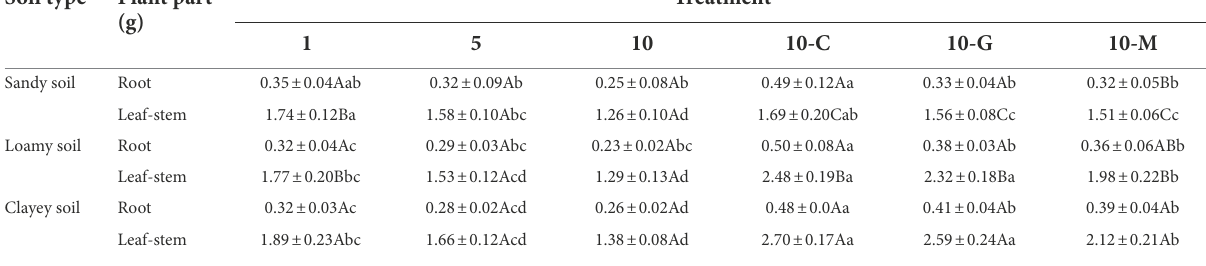
TABLE 2 Effects of root exudates on the biomass of root and leaf-stem of Sorghum sudanense under different soil types (g). Soil type Plant part (g)